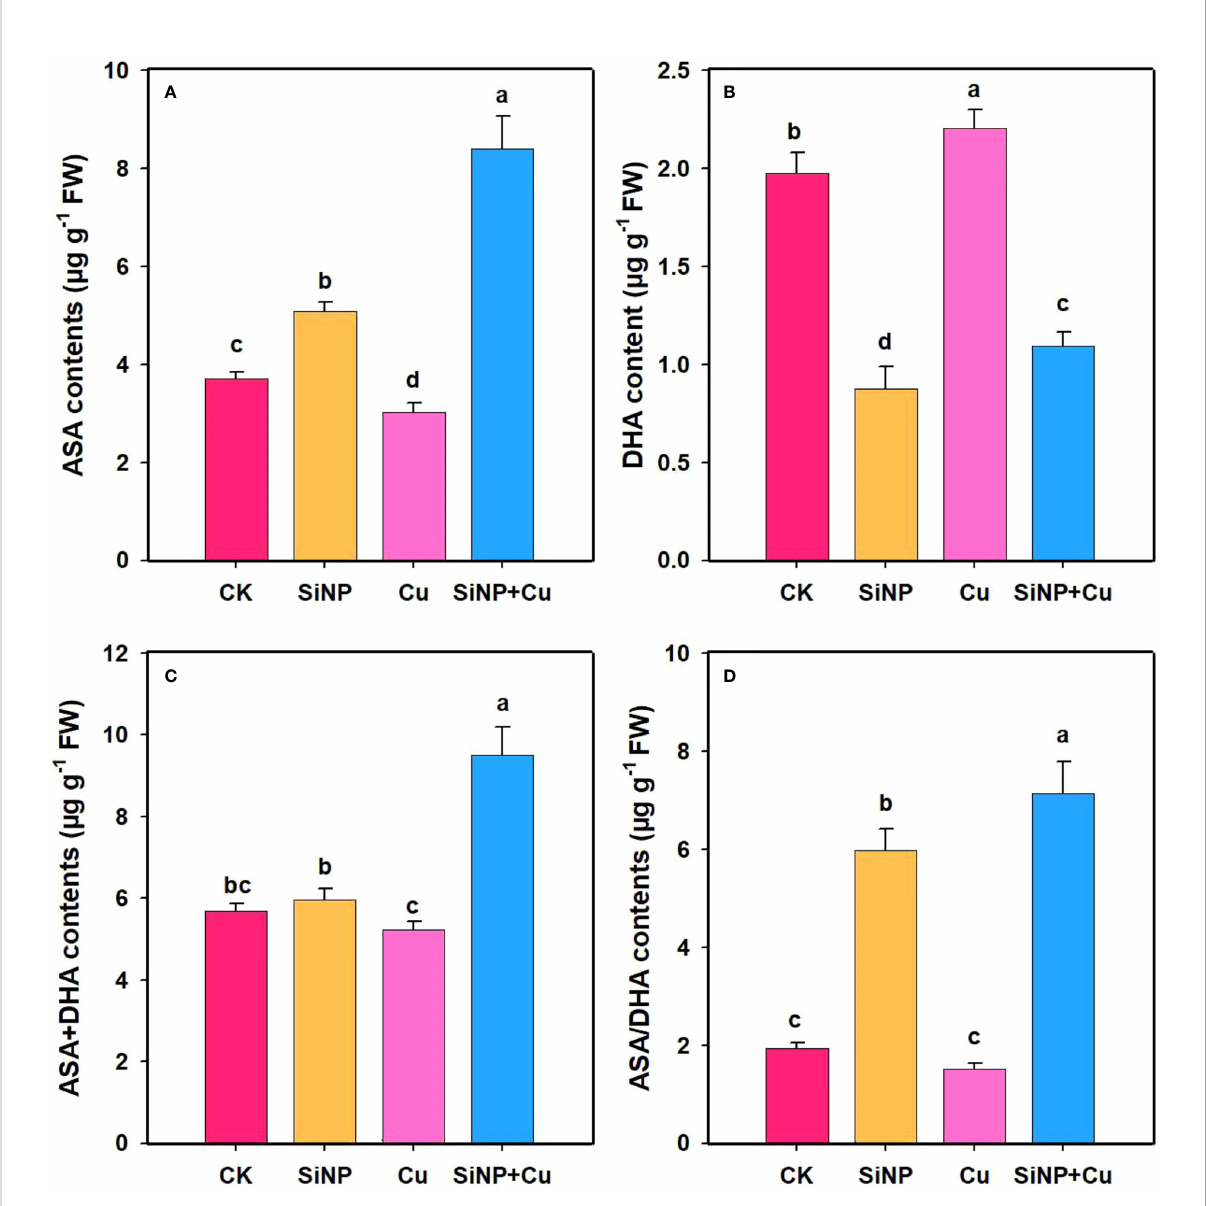
FIGURE 7 ASA contents under Cu 2+ toxicity. Note “ Experimental treatments contained: CK (control); SiNP (2.5 mM SiNPs); Cu (500 µM Cu 2+ alone), SiNP+Cu (2.5 mM SiNPs+500 µM Cu 2+ ). The different letters (a, b, c, d) describe the differences in different treatments by LSD test at (P ≤ 0.05) ” . (A) AsA, (B) DHA, (C) AsA+DHA, (D)